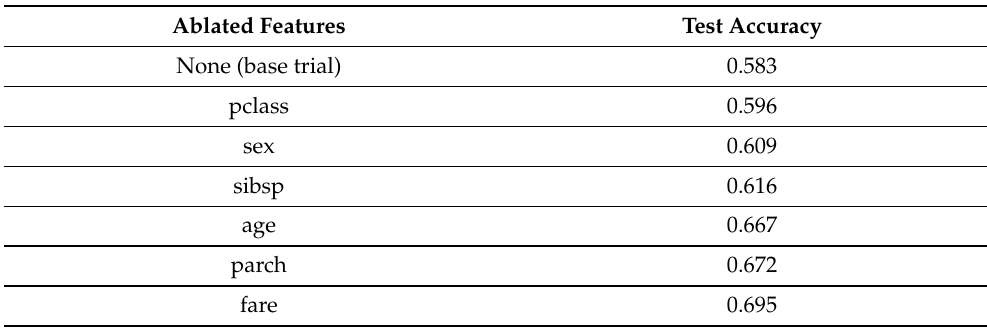
Table 3. A ranking of the average accuracies in the test set in ascending order after ablating each feature from the training set